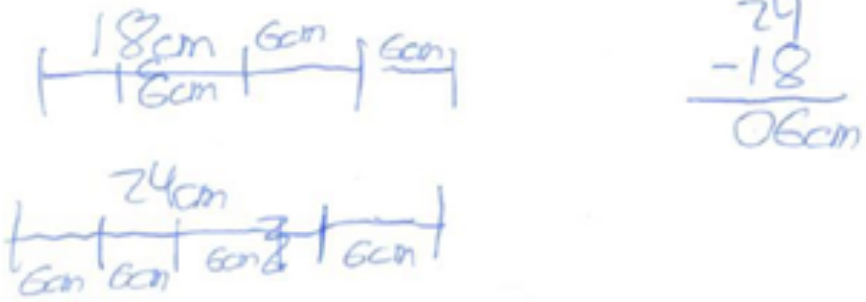
Figure 3. Example of answer with subtraction predisposition for GCDL problem.